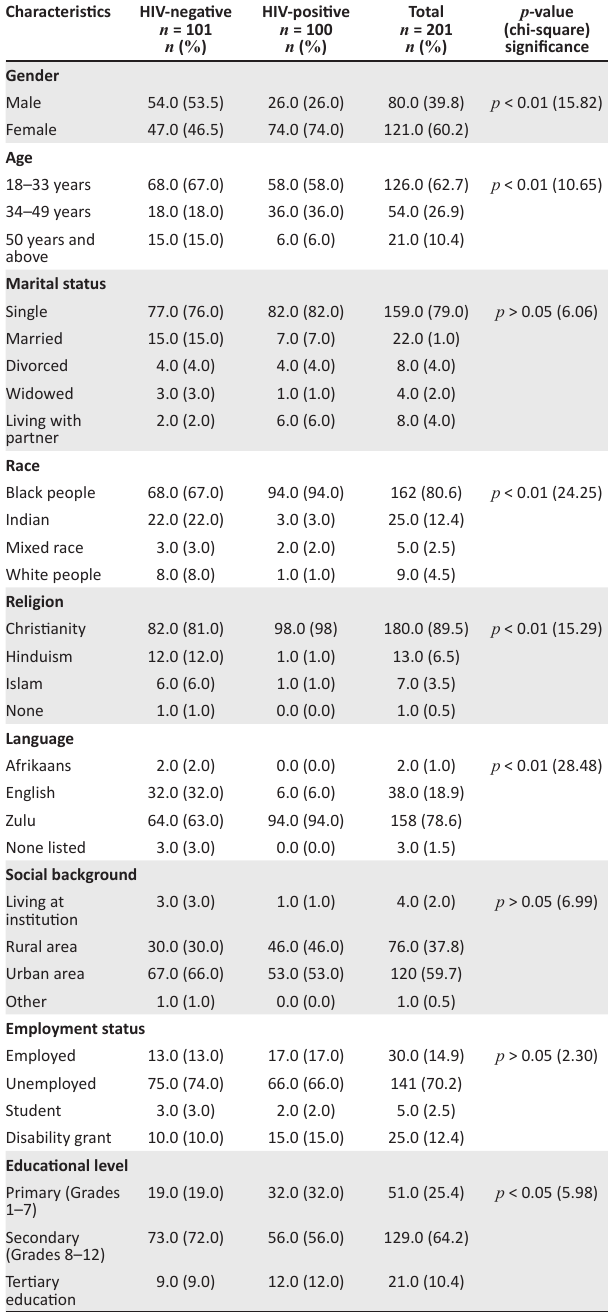
TABLE 1: Socio-demographic characteristics of patients with psychosis.